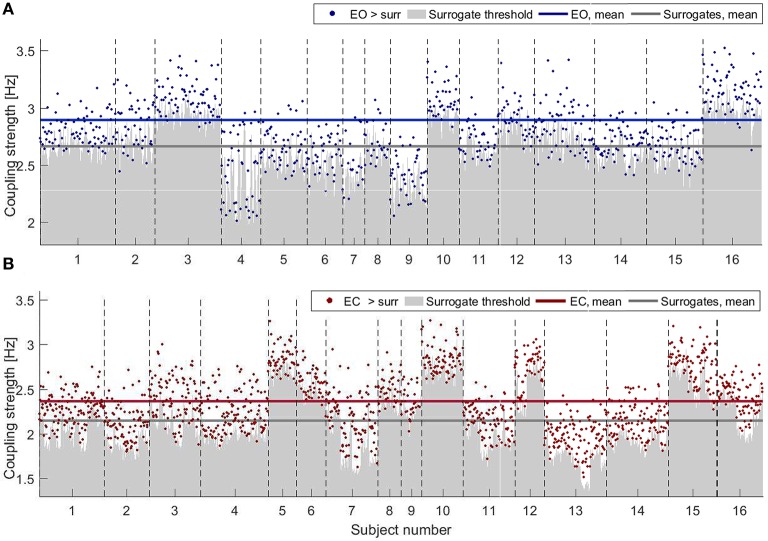
Strengths of the couplings for (A) EO (blue) and (B) EC (red) for all the subjects, shown as consecutive intervals on the x-axes. Only values higher than the corresponding PS surrogate threshold are shown. Couplings are selected when their strengths are higher than the mean+2STD of the corresponding surrogate distribution (gray shading). Horizontal lines indicate the average values of the surrogates and of the validated couplings (color-scheme as explained above).